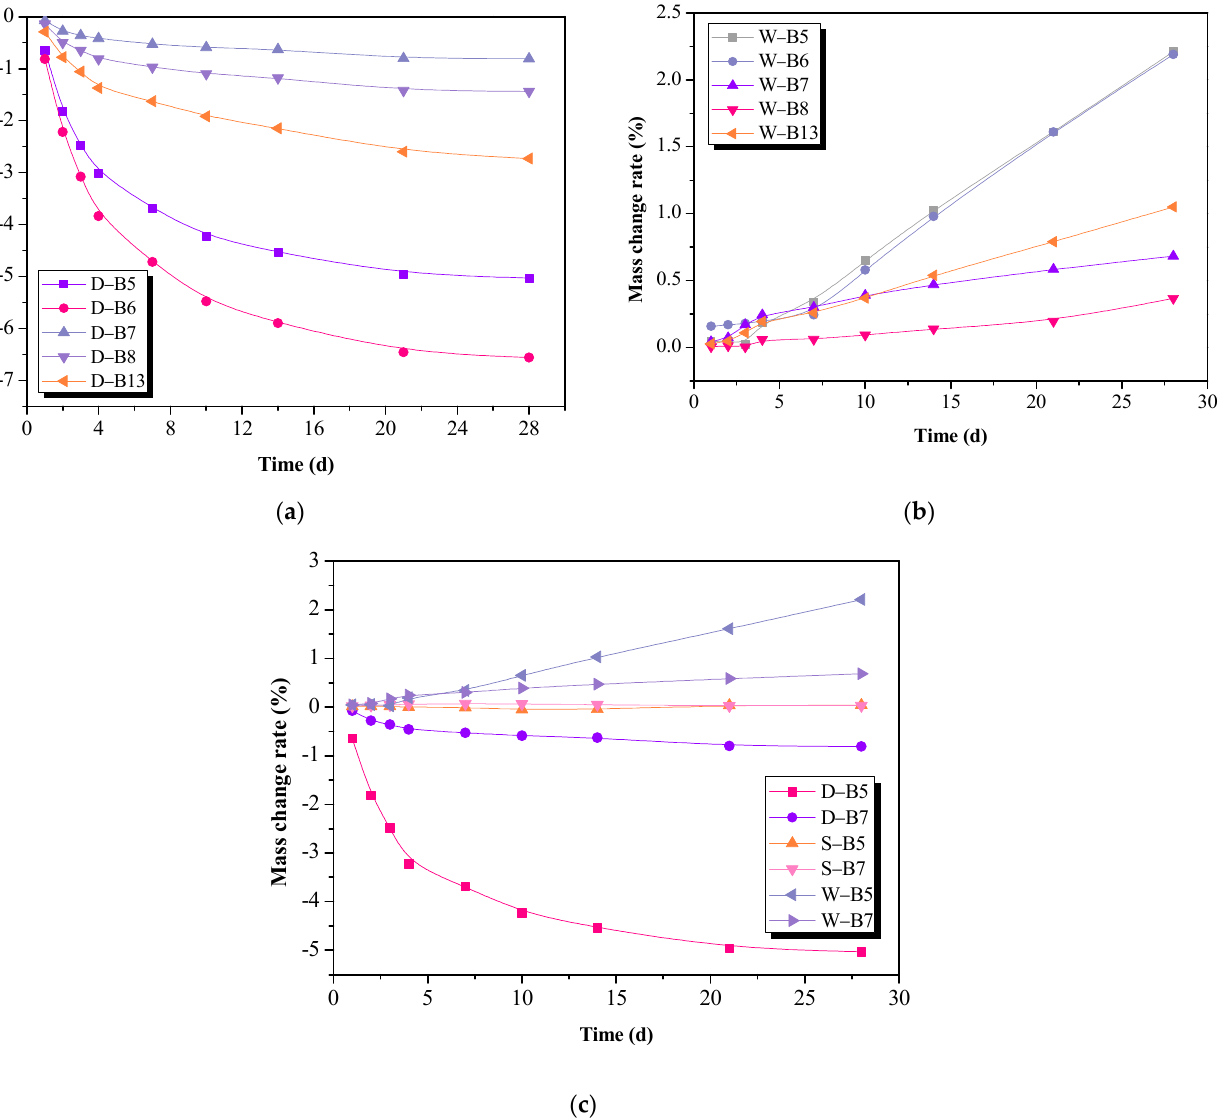
Figure 3. Effect of three curing conditions on the mass change rate of AA-FASM. ( a ) Dry curing. ( b ) Water-saturation curing. ( c ) Mass change rates of B5 and B7.